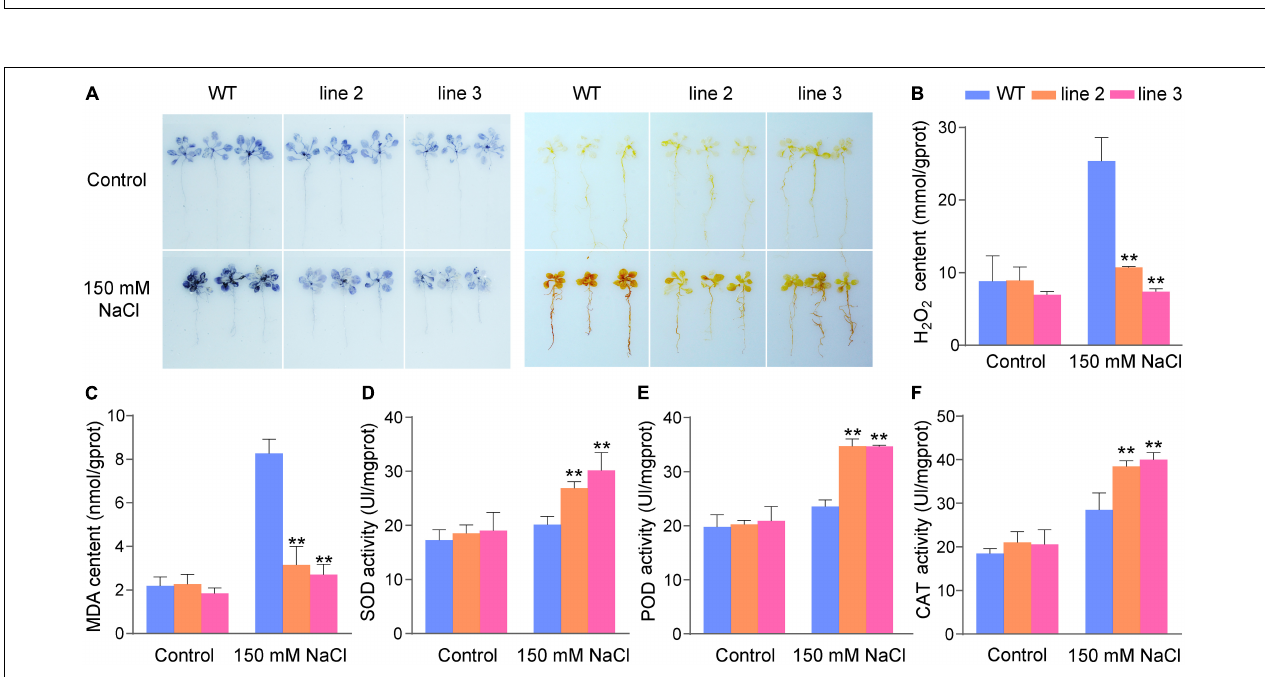
FIGURE 4 | Analysis of ROS level and ROS scavenging ability of transgenic Arabidopsis under salt stress treatment. (A) Analysis of ROS production in intact plants by NBT and DAB staining. (B) Analysis of H 2 O 2 level. (C–F) Analysis of MDA content, SOD, POD and CAT activities, respectively. All experiments were repeated three times. Data are means ± SE from three independent experiments. Significant difference compared with WT plants with the same treatment, LSD multiple comparison test was used: * p < 0.05, ** p < 0.01.